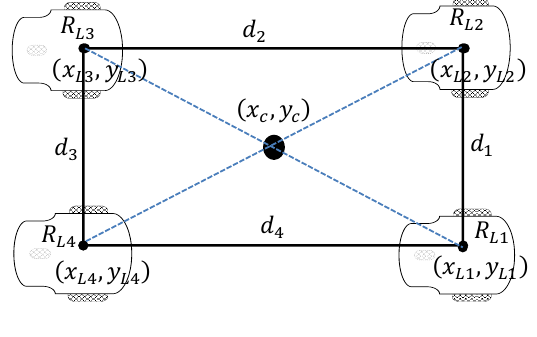
Figure 4. Leader robot formation